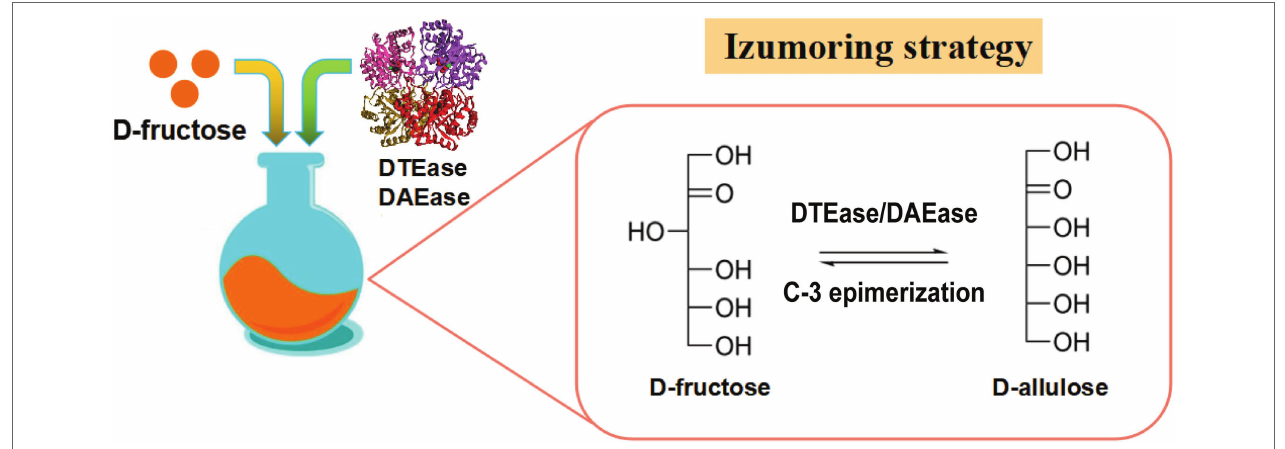
FIGURE 2 | Izumoring strategy for production of D-allulose. DTEase, D-tagatose 3-epimerase; DAEase, D-allulose 3-epimerase.